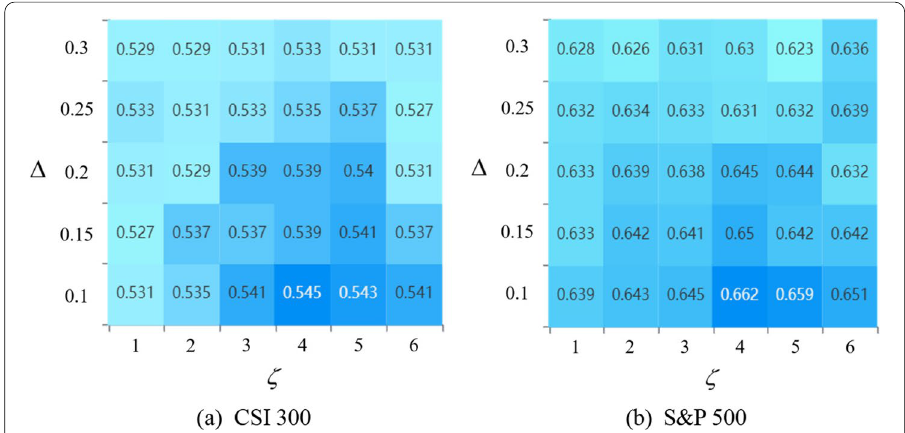
Fig. 9 Prediction accuracy under different combinations of two parameters in each stock